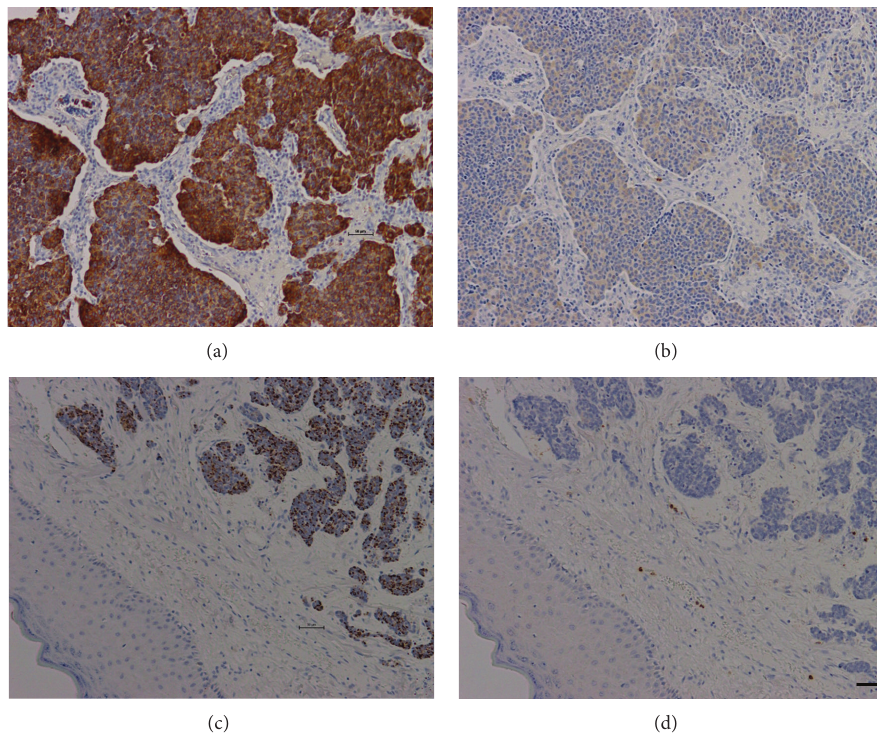
Figure 4: Immunohistochemistry in representative Merkel cell carcinoma tumors with good and poor prognoses. (a) intermediate KRT20 staining in poor prognosis tumor. (b) Weak KIF3A staining in poor prognosis tumor. (c) Weak punctate KRT20 staining in good prognosis tumor. (d) Negative (absent) KIF3A staining in good prognosis tumor. All images were taken at 10X magnification with Nikon digital DS-Fi1 high definition color camera on the Nikon Eclipse 90i. Scale bar = 50 𝜇 m.